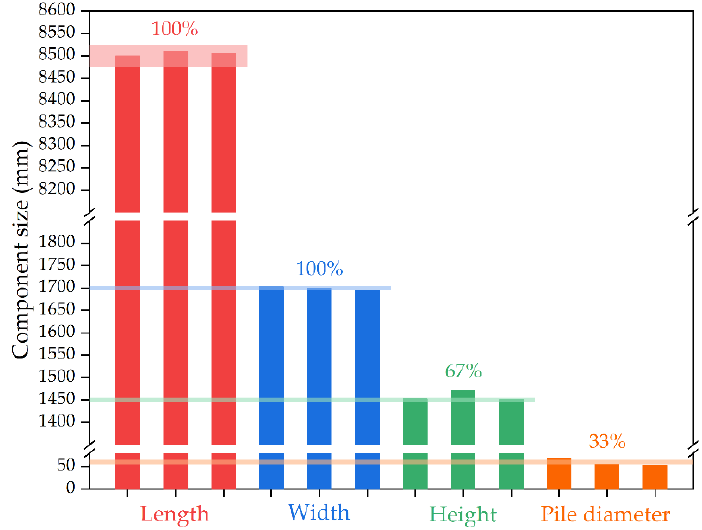
Figure 10. The component size values of prefabricated cap beam specimens.